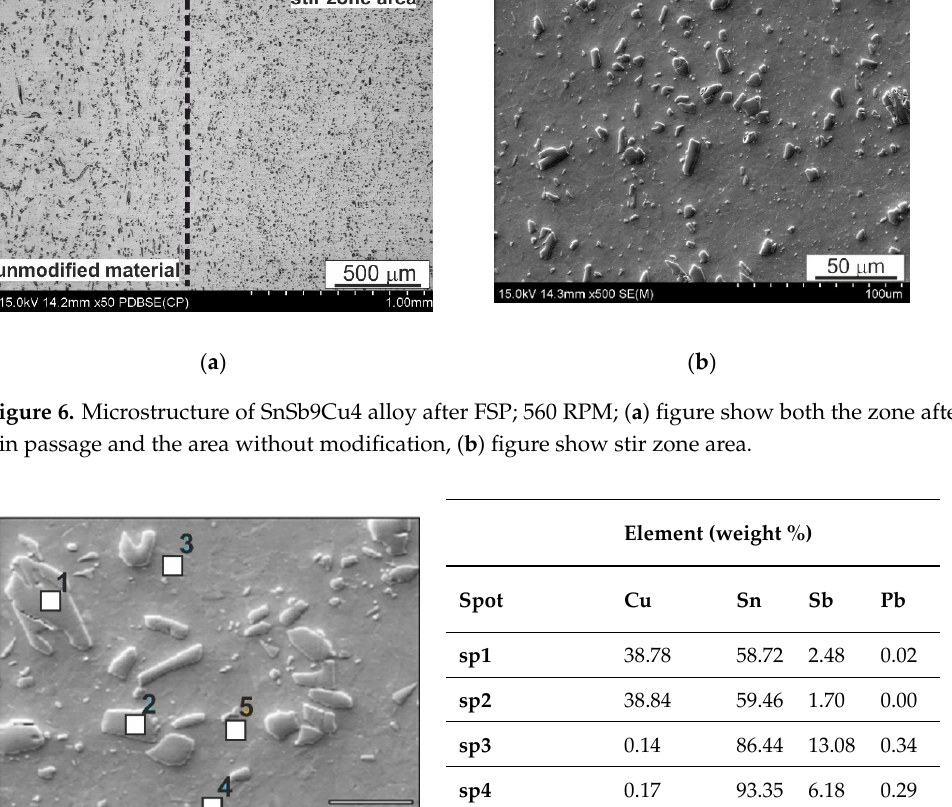
Figure 5. Microstructure of SnSb9Cu4 alloy after FSP; 280 RPM; ( a ) figure show both the zone after pin passage and the area without modification, ( b ) figure show stir zone area.